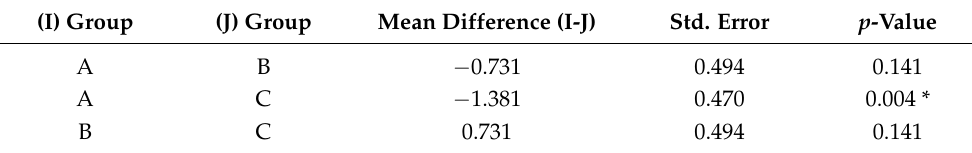
Table 5. Pairwise comparisons between groups of follow-up